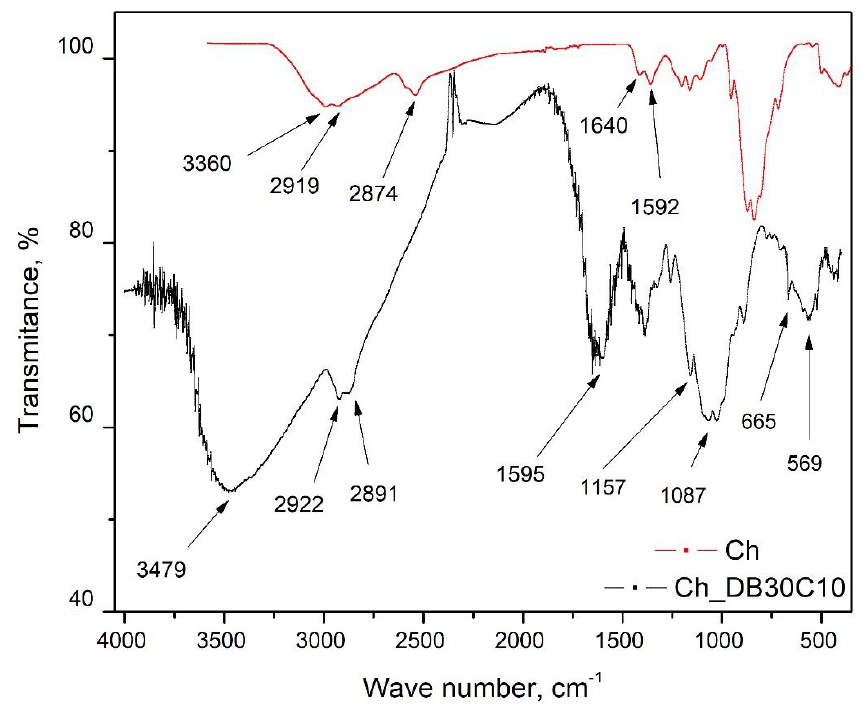
Figure 2. FT-IR spectroscopy.